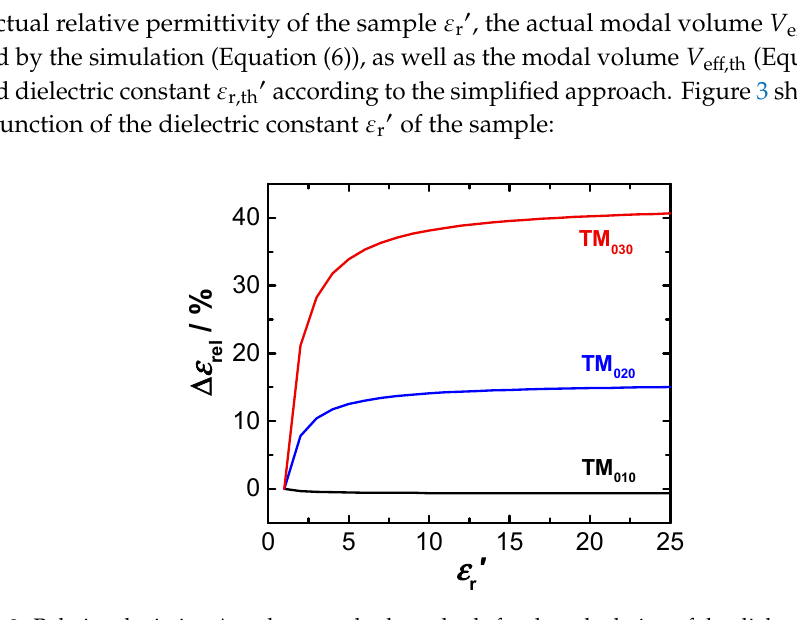
Figure 3. Relative deviation ∆ ε rel between both methods for the calculation of the dielectric constant as a function of the dielectric constant of the sample ε r (cid:4593) .